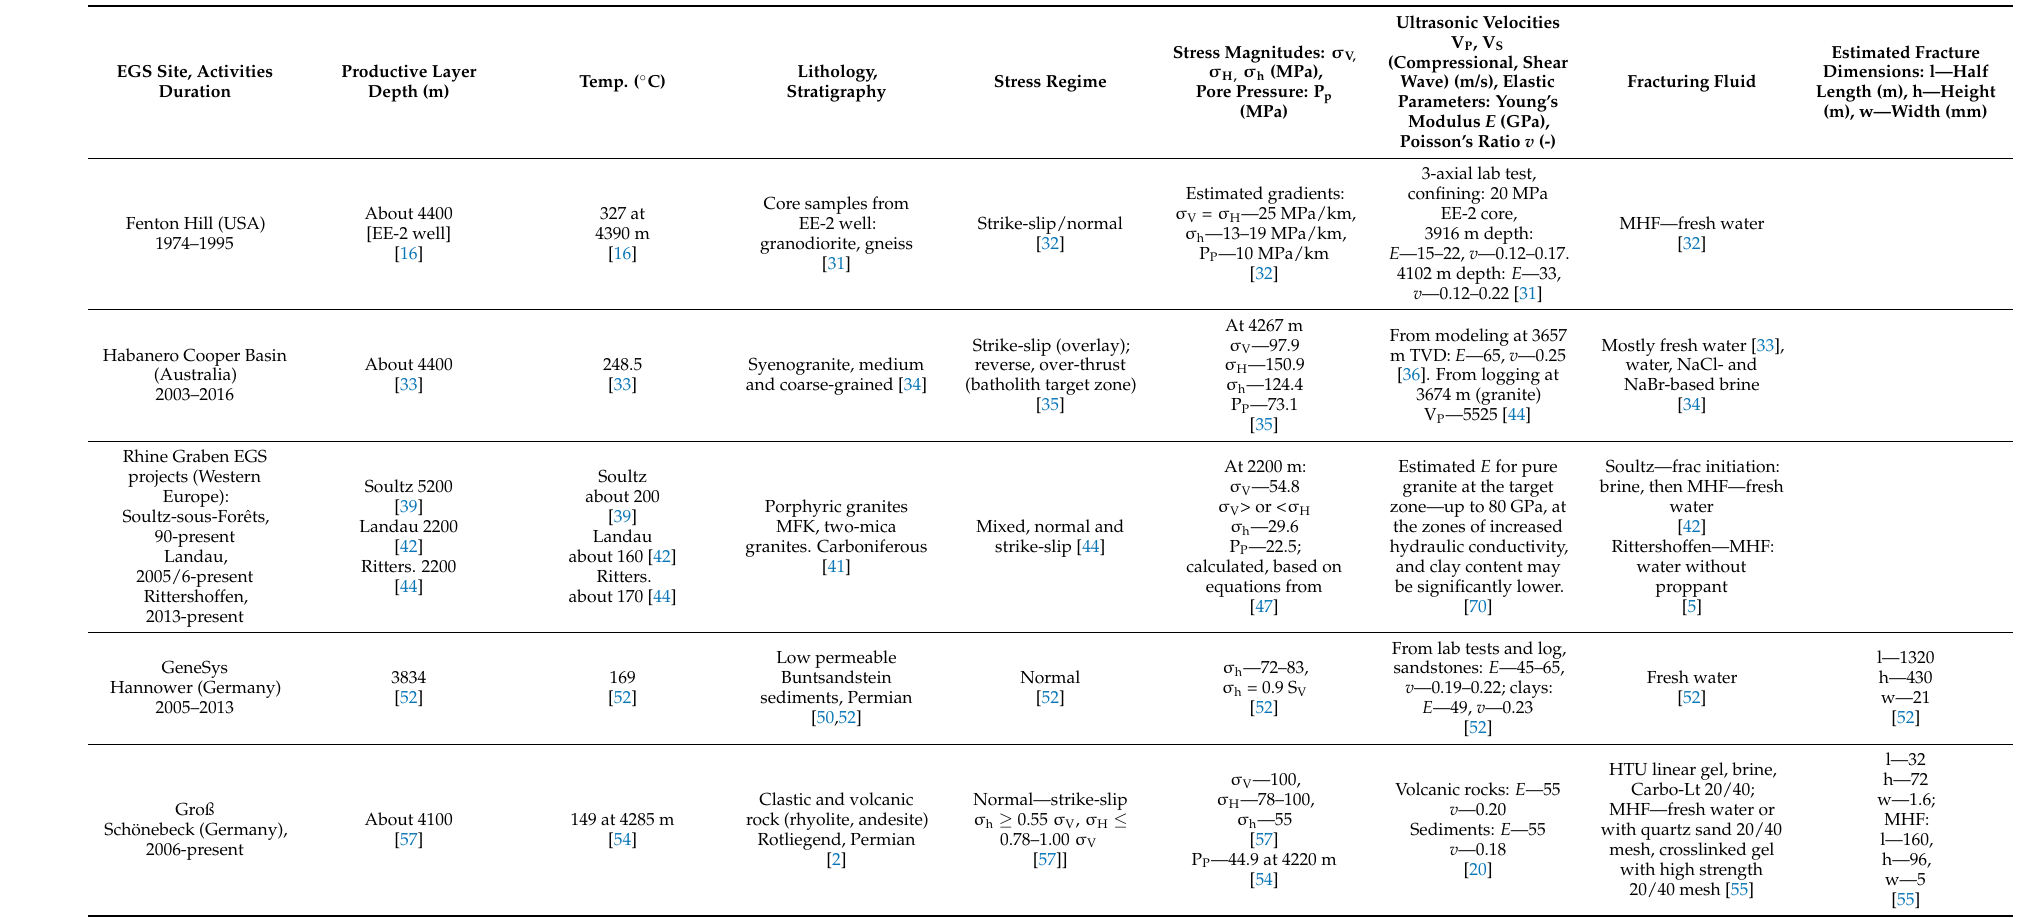
Table 1. Selected geological, tectonic and fracturing data compilation from EGS